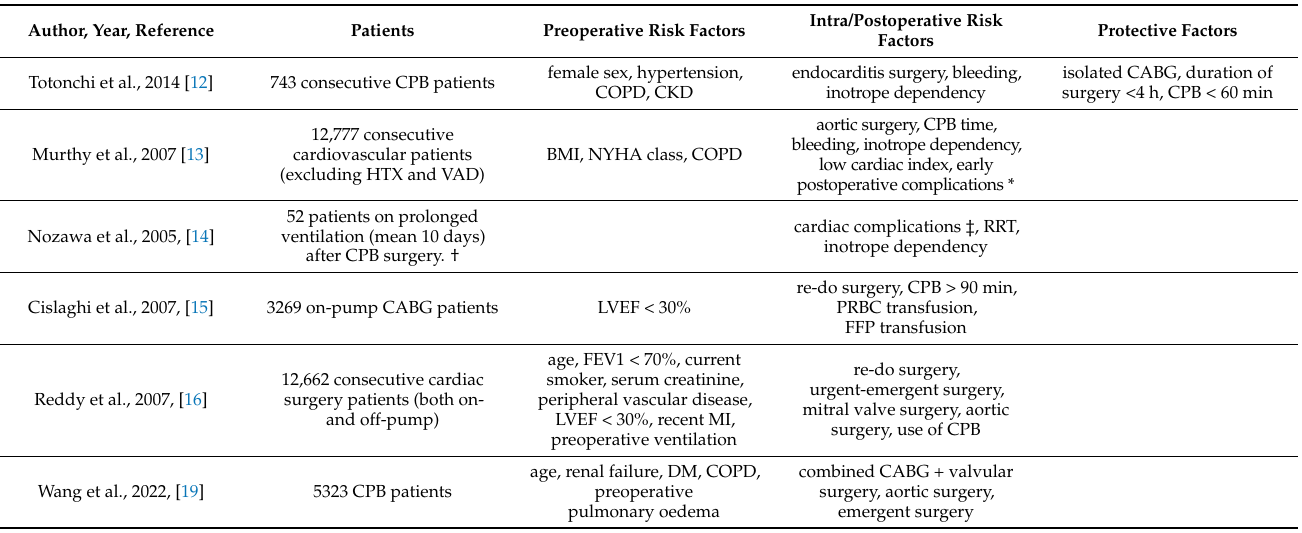
Table 1. Most recent studies on perioperative risk factors for prolonged mechanical ventilation following cardiac